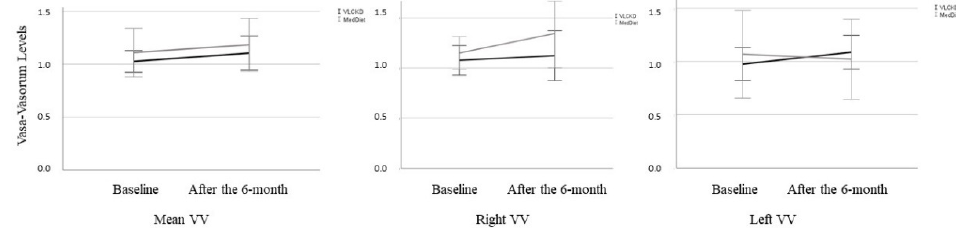
Figure 4. Plot displaying dynamics of vasa-vasorum results at baseline and after the 6-month follow-up period in the intervention groups. Table 4. Changes in the newly proposed lipid-based atherogenic scores between baseline and the 6-month follow-up, according to treatment group, together with an analysis of treatment effect.